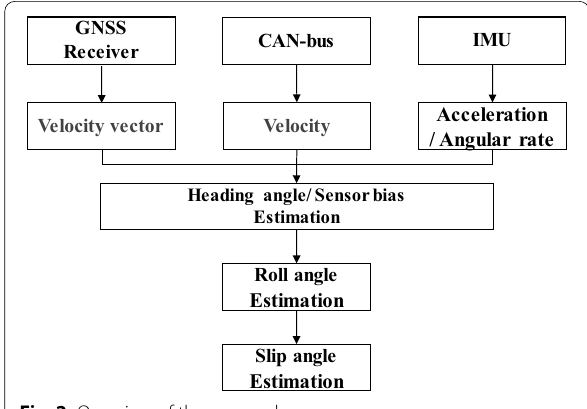
Fig. 2 Overview of the